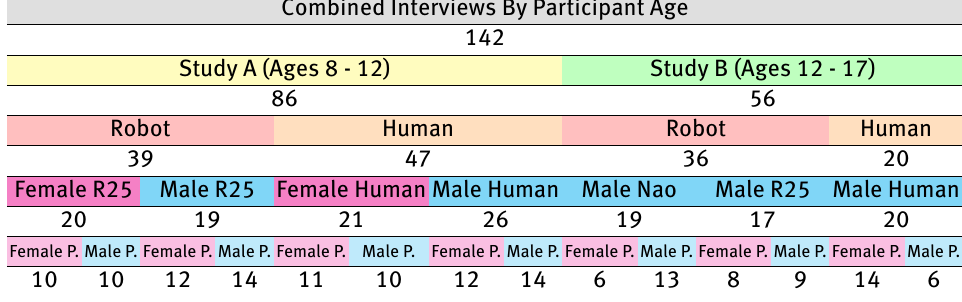
Table 2: Number of participants assigned to each condition between Study A and Study B. Sorted by Study, Interviewer Type, Interviewer Gender, and Participant